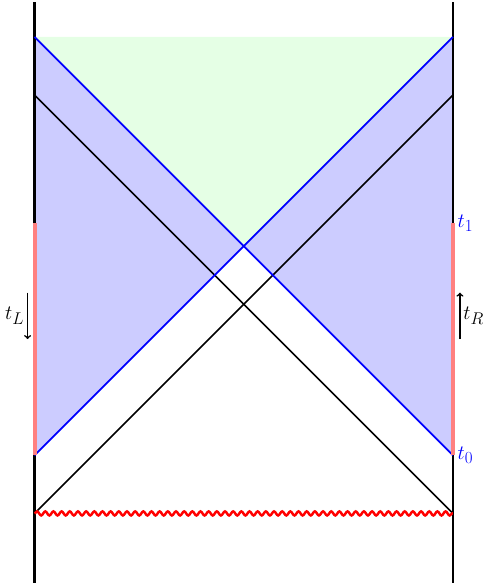
= t 0 and turned o(cid:11) at t R=L (cid:6)